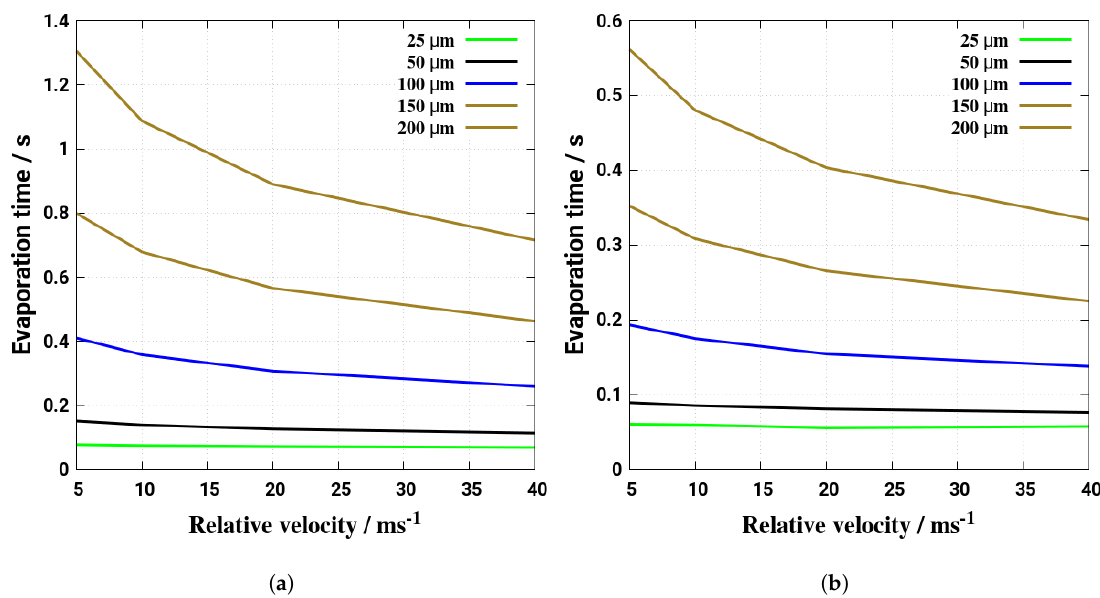
Figure 6. Influence of droplet relative velocity and diameter on evaporation dynamics for gas temperature. ( a ) 573 K; ( b ) 773 K.